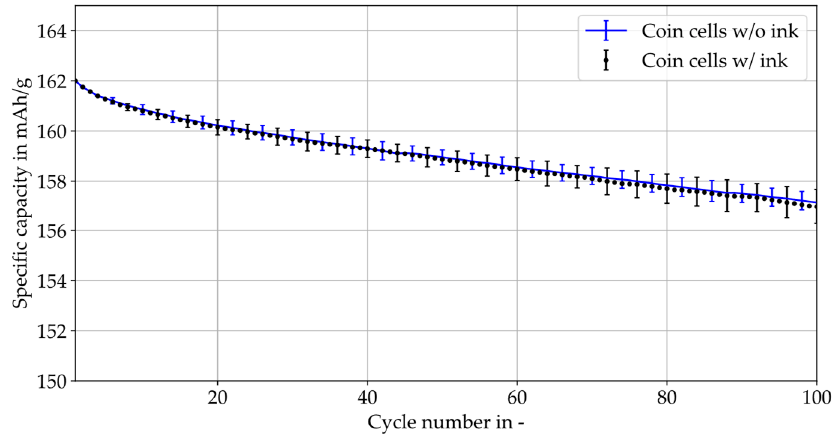
Figure 10. Mean values and standard deviation of the specific capacity in the first 100 cycles of the coin cells with and without ink during the cycling test. The specific capacity of each coin cell was compared to a theoretical value of 162 mAh/g in the beginning.